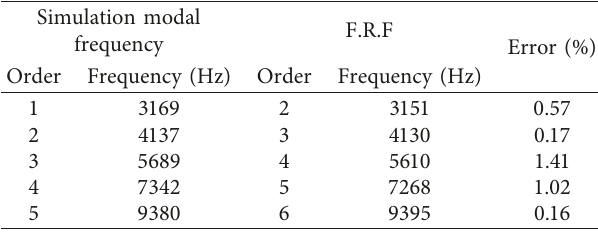
Table 6: Experimental verification on simulation modal frequency of the brake pad.